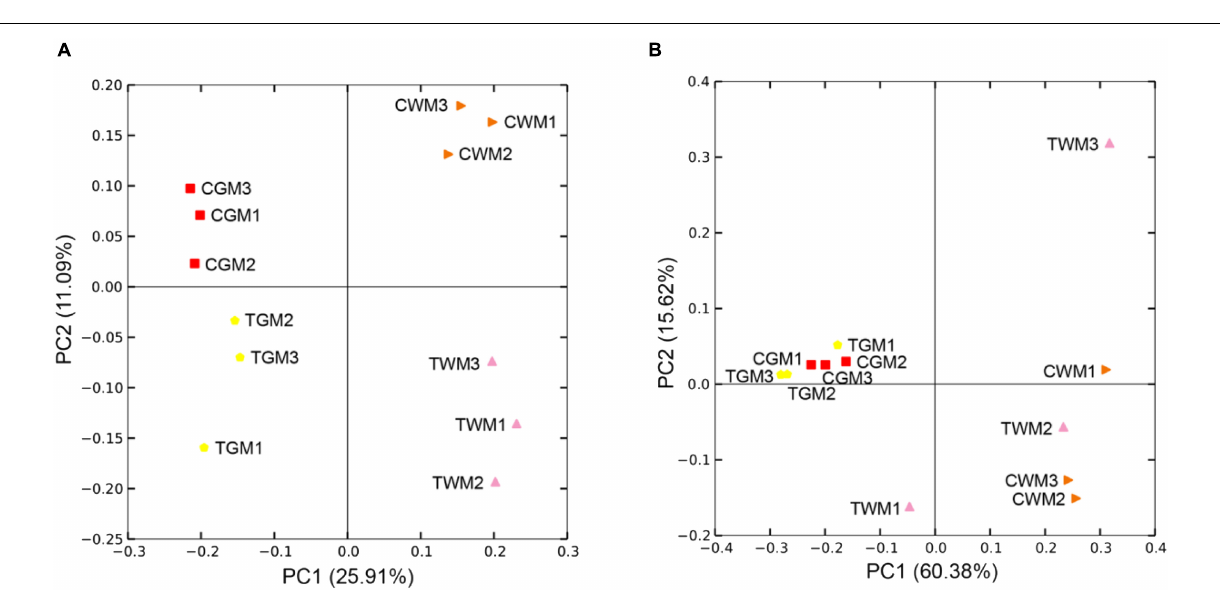
FIGURE 6 | Principal coordinates analysis (PCoA) of the unweighted (A) and weighted (B) UniFrac scores of the microbial communities. Unweighted principal components (PCs) 1 and 2 explain 25.91 and 11.09% of the variance, while 60.38 and 15.62% based on weighted principal components,